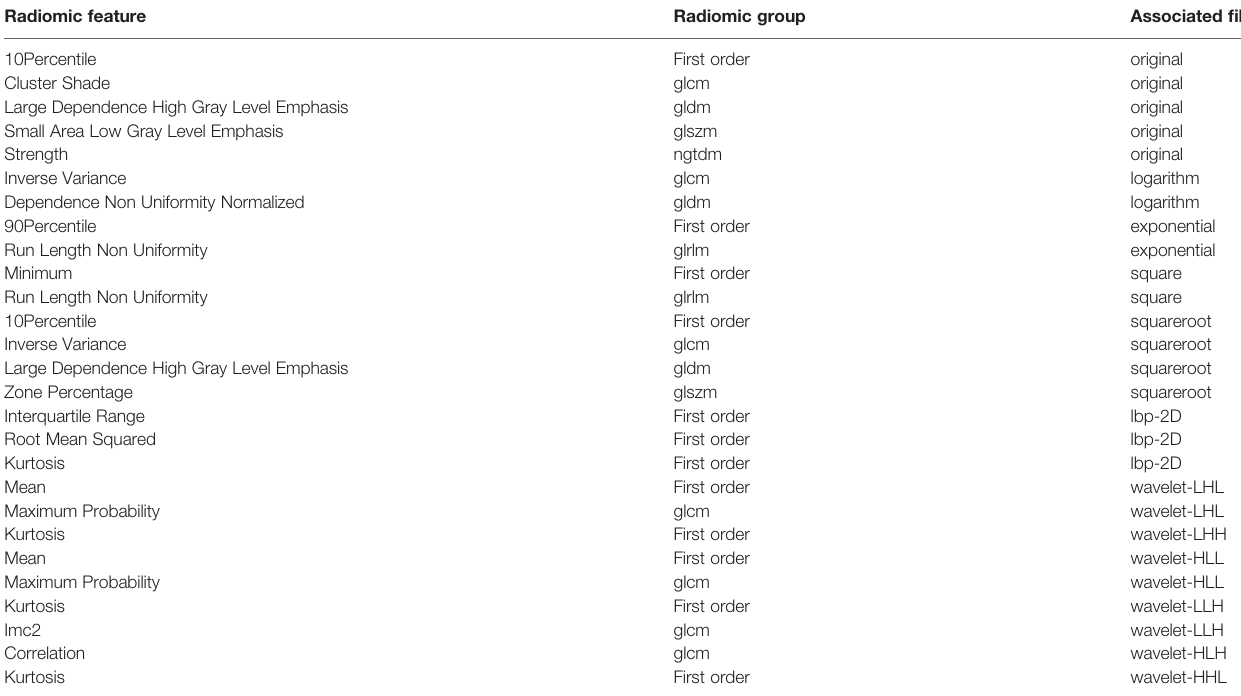
TABLE 1 | Description of the selected radiomic features with their associated feature group and fi lter.